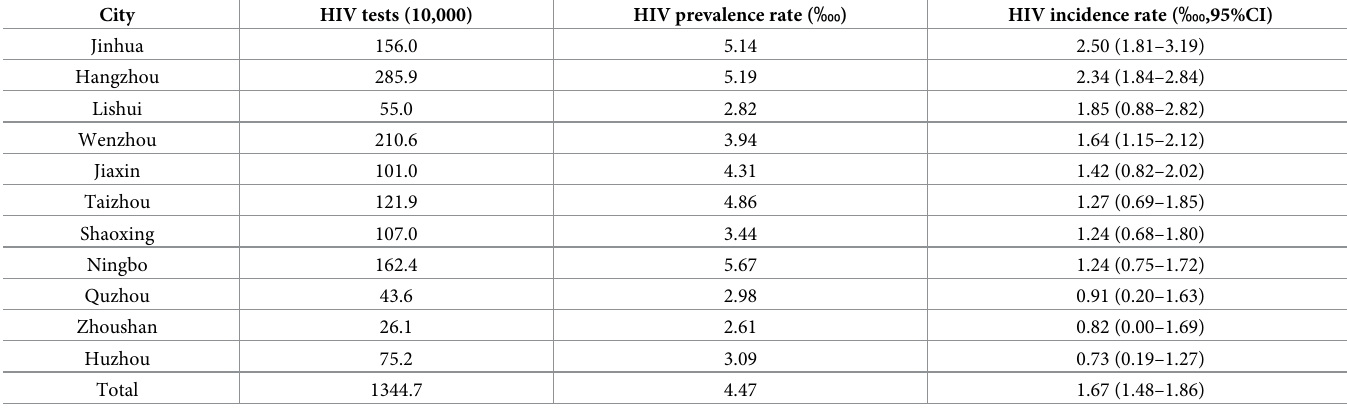
Table 1. HIV testing, HIV prevalence, HIV incidence rate in 11 cities in Zhejiang province, 2018.